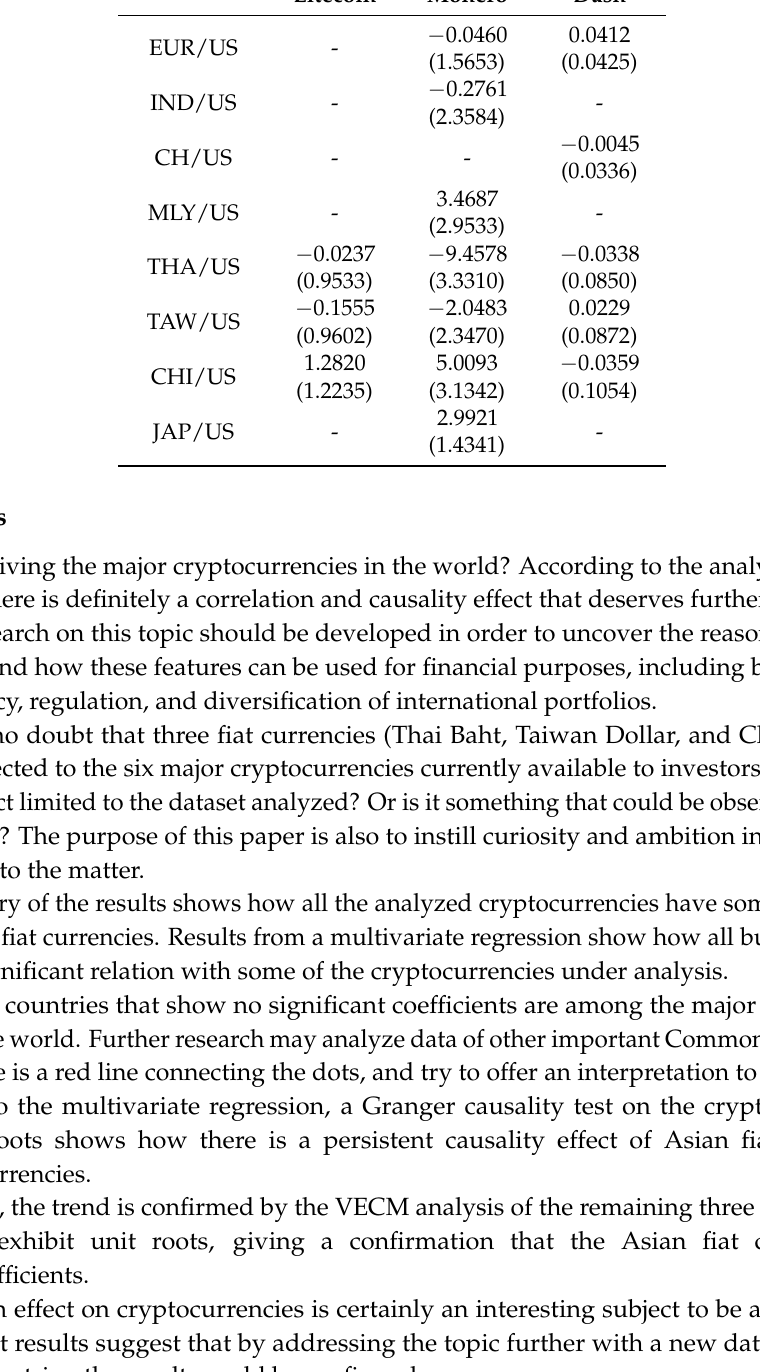
Table 9. VECM analysis on Litecoin, Monero, and Dash, against their respective driving fiat currencies. Litecoin